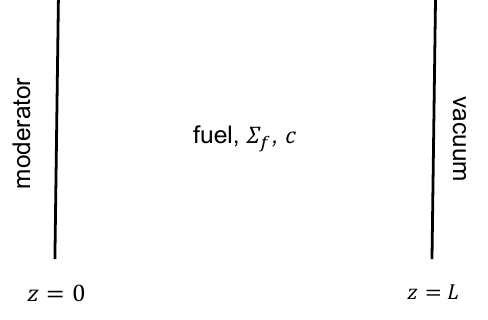
Figure 1. Eigenvalue Doppler Slab problem